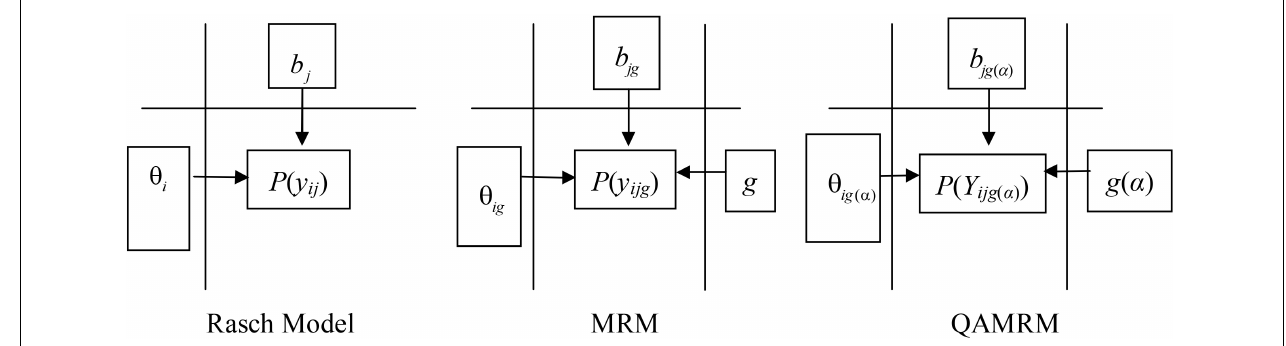
FIGURE 1 | Comparison among the Rasch model, MRM, and